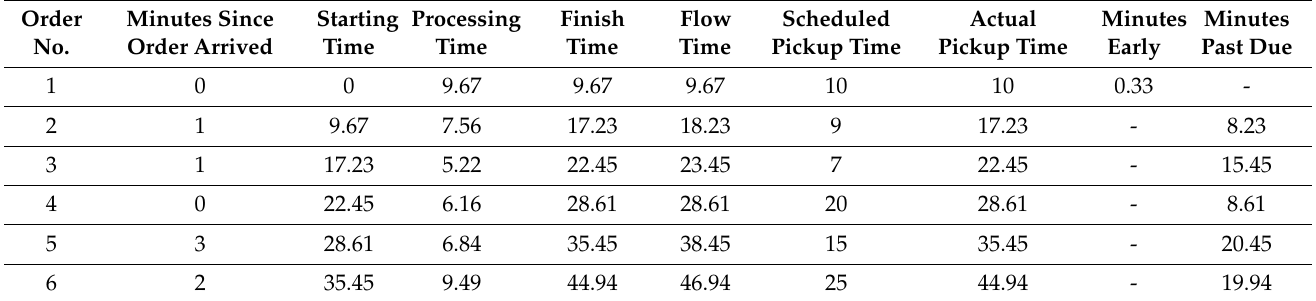
Table 6. Sequence of orders based on FCFS